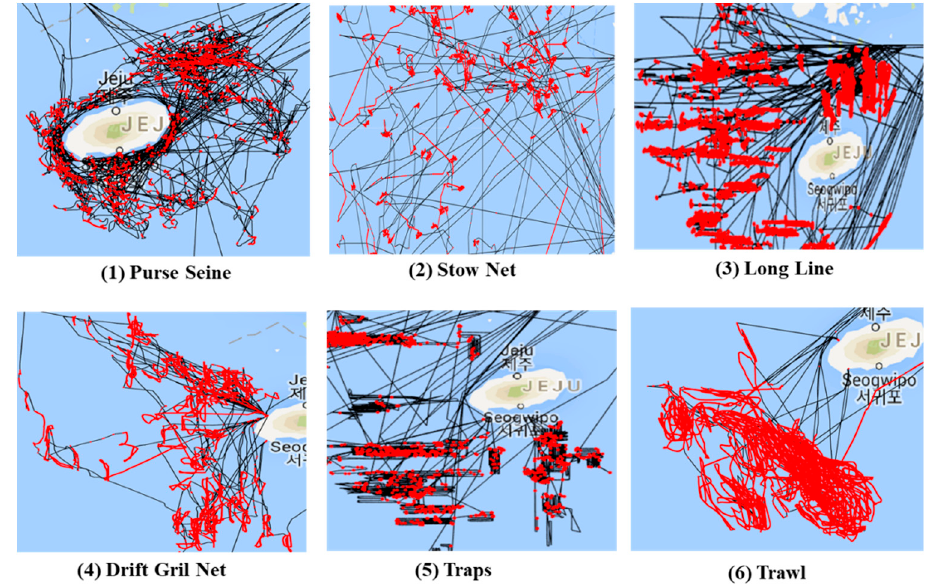
Figure 8. Spatial trajectory distributions for fishing gear types: the black tracks indicate a section with a speed of 6 knots or more and red indicates ones with a speed of less than 6 knots.